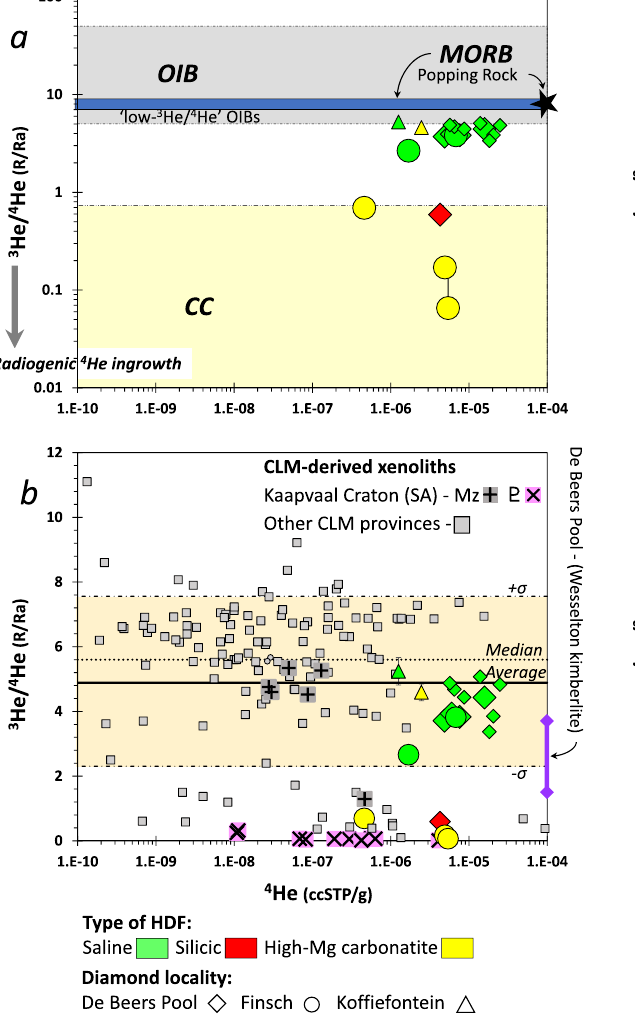
Fig. 1 Helium content and 3 He/ 4 He ratios of HDF-bearing diamonds from De Beers Pool and Finsch mines. Compositional type of high-density supercritical fl uid (HDF) microinclusions and diamond mine locality are coded by color and shape, respectively. Additional literature data (small symbols) for De Beers Pool and two diamonds from the neighboring Kof fi efontein mine 54 are also shown. The 4 He content and 3 He/ 4 He errors represent standard deviation and are smaller than the size of the symbols for the majority of data points. For comparison we plot: a The 3 He/ 4 He range for mid-ocean ridge basalts (MORB) 51 , ocean island basalts (OIB) 52 , continental crust (CC) 53 , and the values for a gas-rich MORB, the “ Popping Rock ” 99 . With time 3 He/ 4 He ratios decrease due to U-Th decay (indicated by the shaded arrow left of the y -axis). b Published He content and 3 He/ 4 He for continental lithospheric mantle (CLM)-derived xenoliths, and their average and median 3 He/ 4 He values (only data determined by crushing analyses are presented, as opposed to heating and fusion; dashed lines represent the ±standard deviation on the average; Supplementary Data 2 69 ). Symbols for Kaapvaal craton xenoliths are distinguished from other CLM provinces; among these, xenoliths with late-Mesozoic emplacement ages (Mz) show 3 He/ 4 He mostly between 5.5 and 4.5 Ra, whereas xenoliths of Proterozoic ( ϼ ) age (1.2 Ga) are characterized by radiogenic <1 Ra values. Also shown is the range of 3 He/ 4 He ratio of the Wesselton kimberlite from De Beers Pool 81 . All 3 He/ 4 He values are normalized to the atmospheric ratio Ra = 1.39 × 10 − 6 .